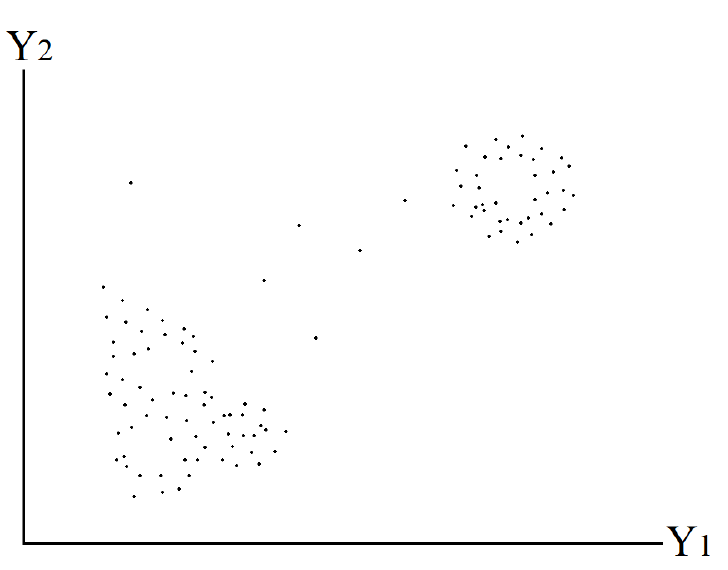
Figure 1. Illustration of the collected historical data in the Cartesian coordinates.